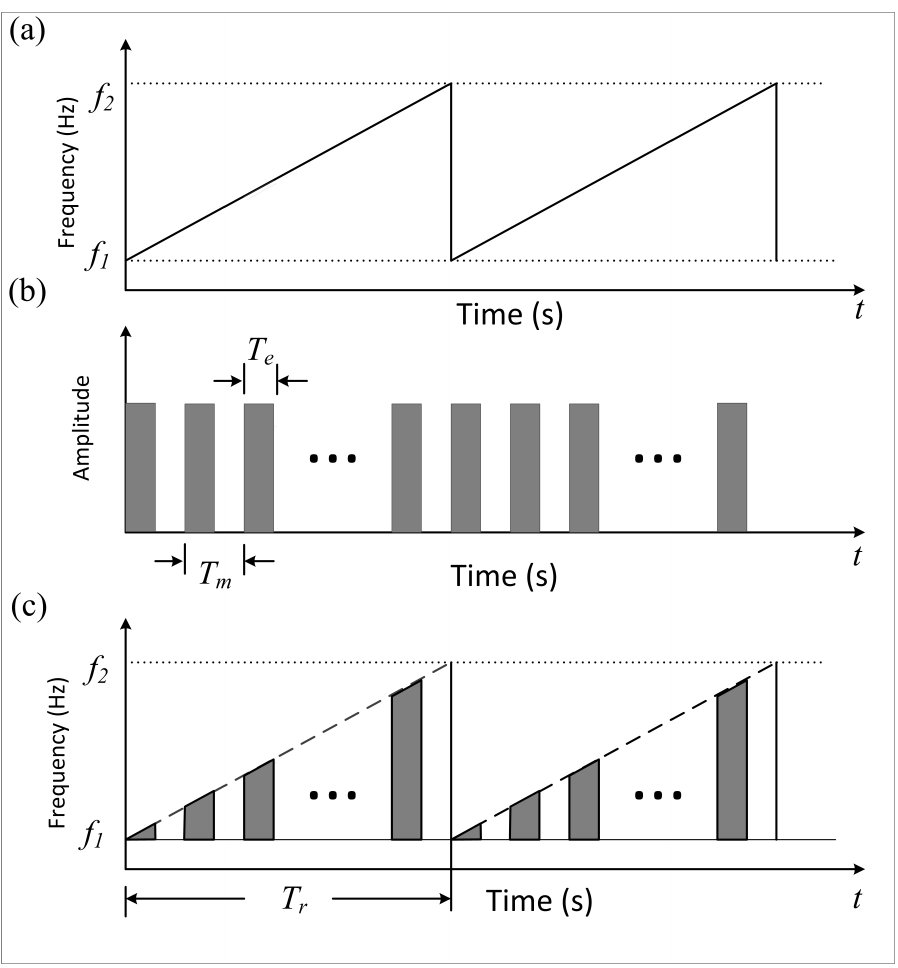
Figure 1. Example of ( a ) frequency-time plot for frequency-modulated continuous waveform (FMCW) signal, ( b ) gate function, and ( c ) frequency-time plot for frequency-modulated interrupted continuous waveform (FMICW) signal. f 1 and f 2 are the starting and ending frequencies, respectively. T r is the frequency sweep interval. T m and T e are the period and the time width of the gate function,